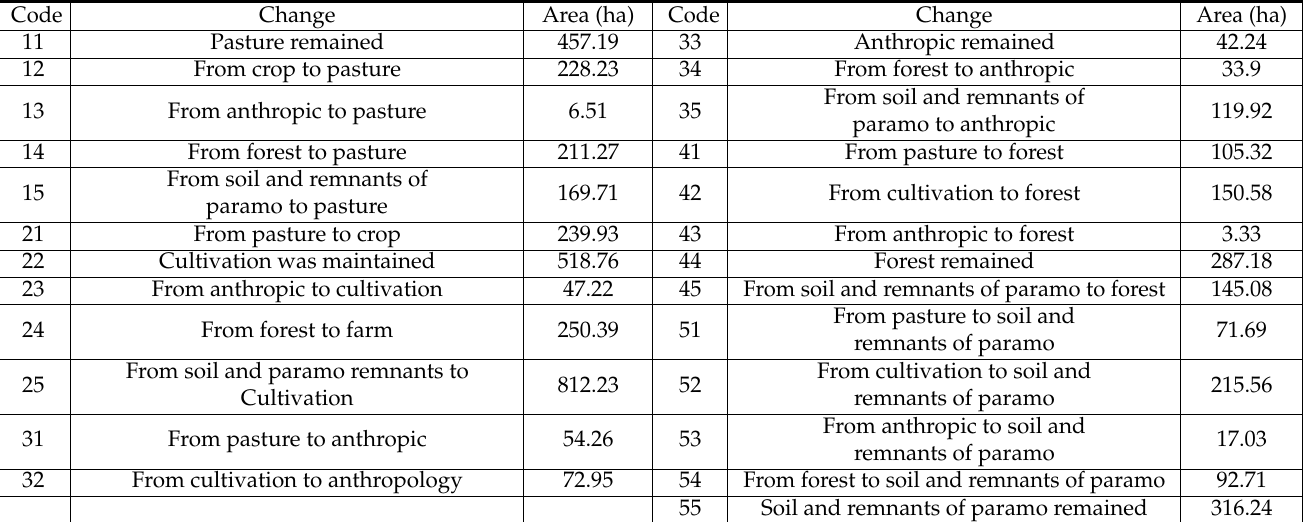
Figure 3. Losses and profits in the time interval 2000–2009. Table 8. Coverage transitions in terms of the area in the time interval